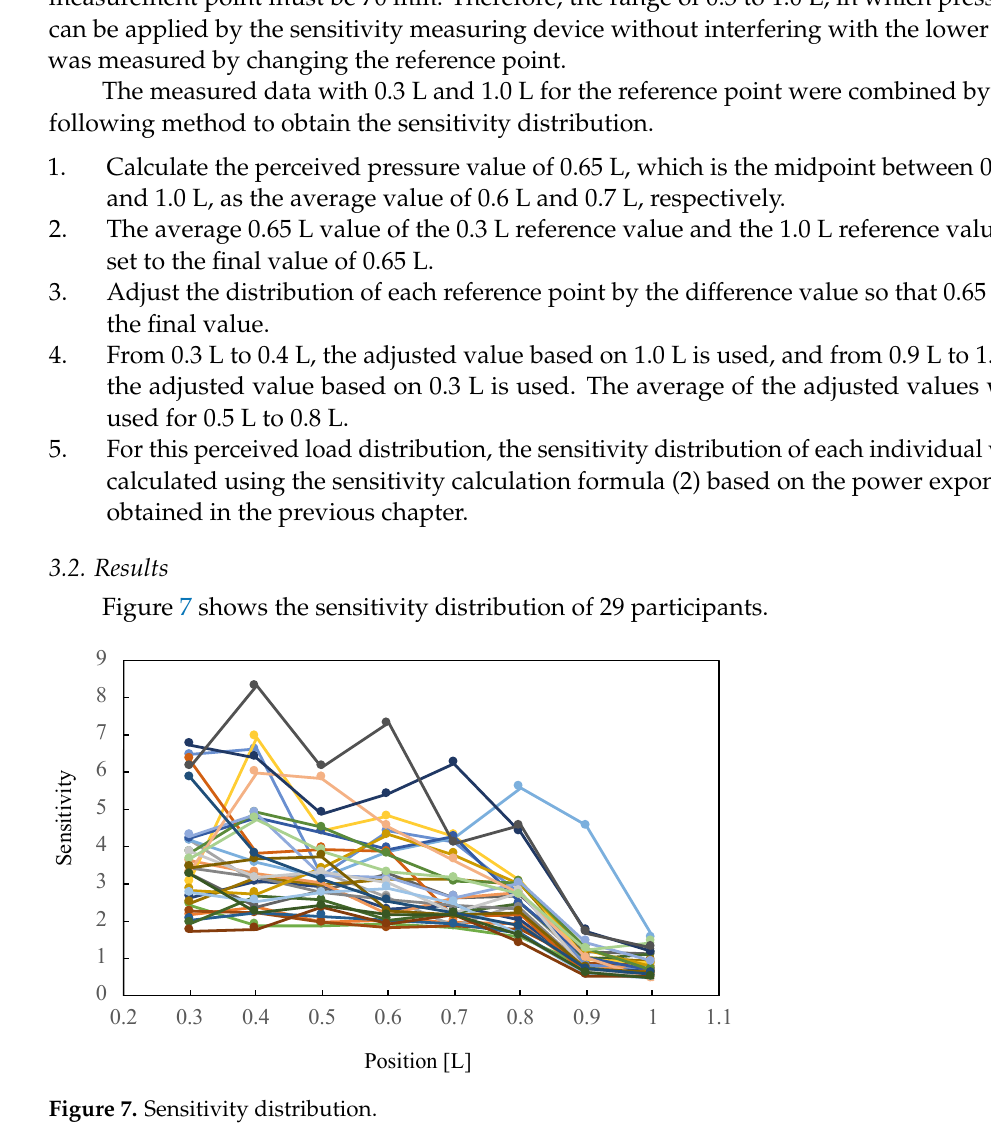
Table 2. Types of sensitivity.